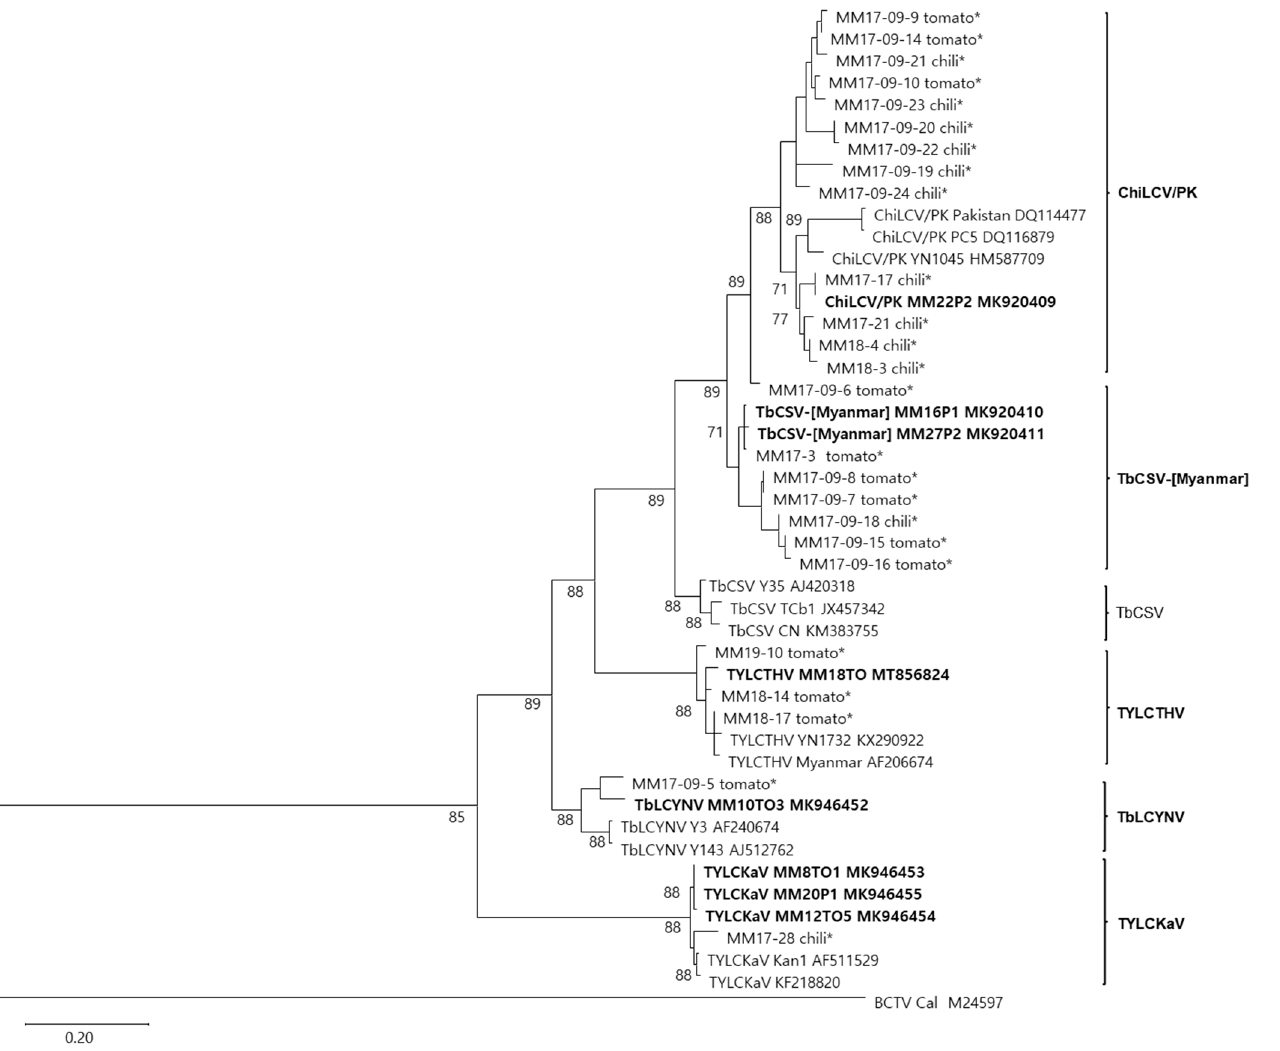
Figure 4. Phylogenetic analysis based on the nucleotide sequences of the CP gene of 33 isolates of begomoviruses collected from tomato and pepper plants in this study and the corresponding sequences of begomoviruses previously reported in GenBank. Phylogenetic trees were reconstructed by maximum likelihood in MEGAX using the TN93 + G model. The bootstrap values are indicated at the nodes (based on 1000 replicates) and only bootstrap values greater than 50% are shown. The tree was rooted using Beet curly top virus (BCTV: accession no. M24597) as an outgroup. Viral isolates for which the DNA-A genome was sequenced in this study are shown in bold. The other viral isolates for which the partial CP genes were sequenced in this study are indicated by asterisks as 'isolate name-host plant' and their sequences are given in the supplementary file.